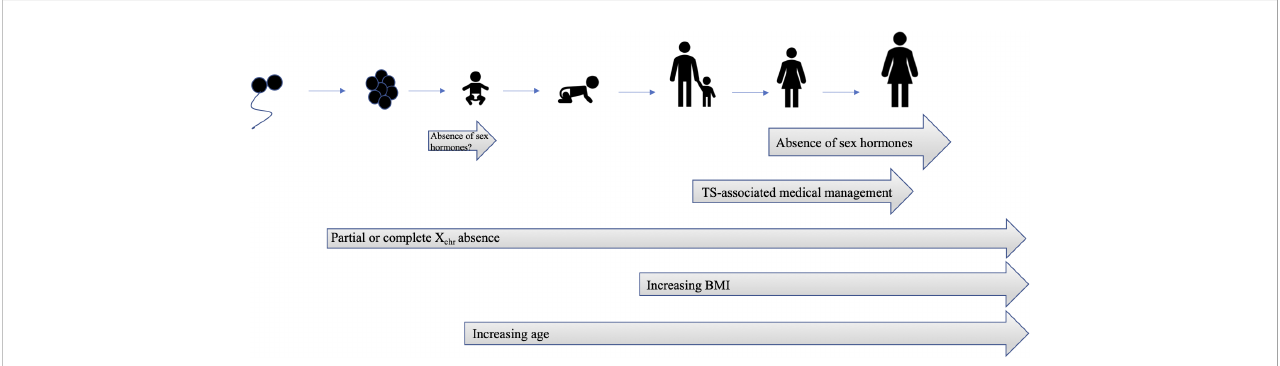
FIGURE 2 Evolution of risk factors for TS-associated hyperglycemia. There is an intrinsic risk of hyperglycemia due to syndrome-speci fi c X chr factors that is present at birth. Similar to type 2 DM in the general population, the risk for hyperglycemia increases with age and BMI. Temporary increases in insulin resistance are attributable to medical therapy, such as recombinant GH, and improve after discontinuation of therapy. Gonadal insuf fi ciency and decreased production of sex hormones also contributes to risk of hyperglycemia, although is